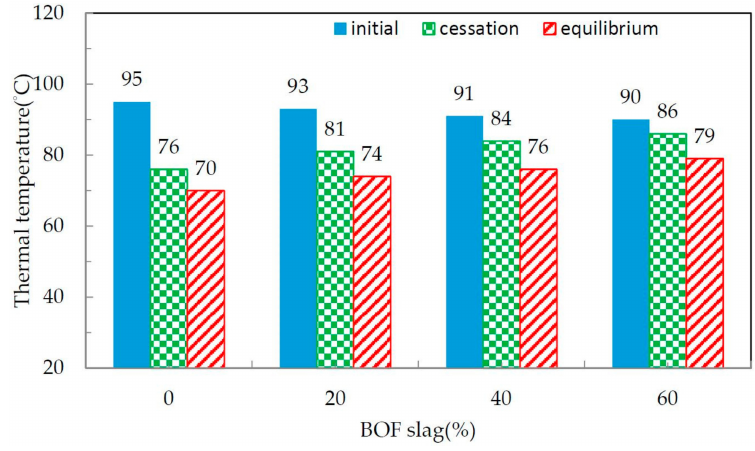
Figure 5. Relationship between the temperature intervals and the BOF slag contents (dense).